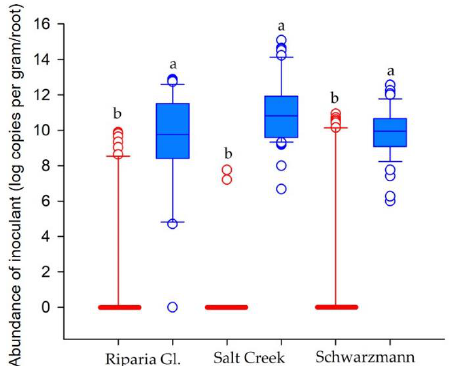
Figure 4. DNA copies per gram of roots (log(x)) of Rhizoglomus irregulare (DAOM 197198), found in the roots of grapevine rootstocks in the second year of the field study. Red boxes represent control vines and, the blue boxes represent AM fungi inoculated vines. Letters above boxes indicate significant differences within the rootstock (control and inoculated) by t -test ( p < 0.001).